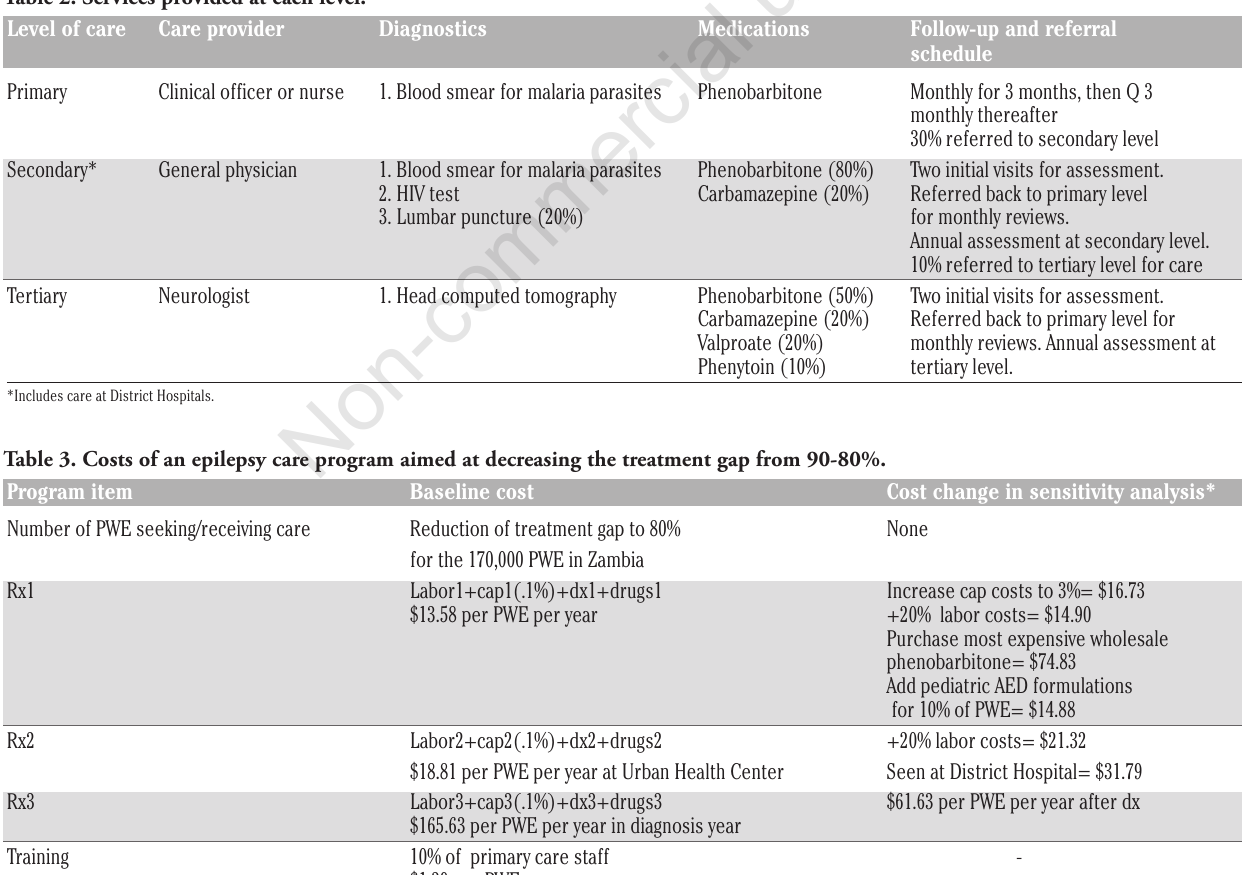
Table 2. Services provided at each level.